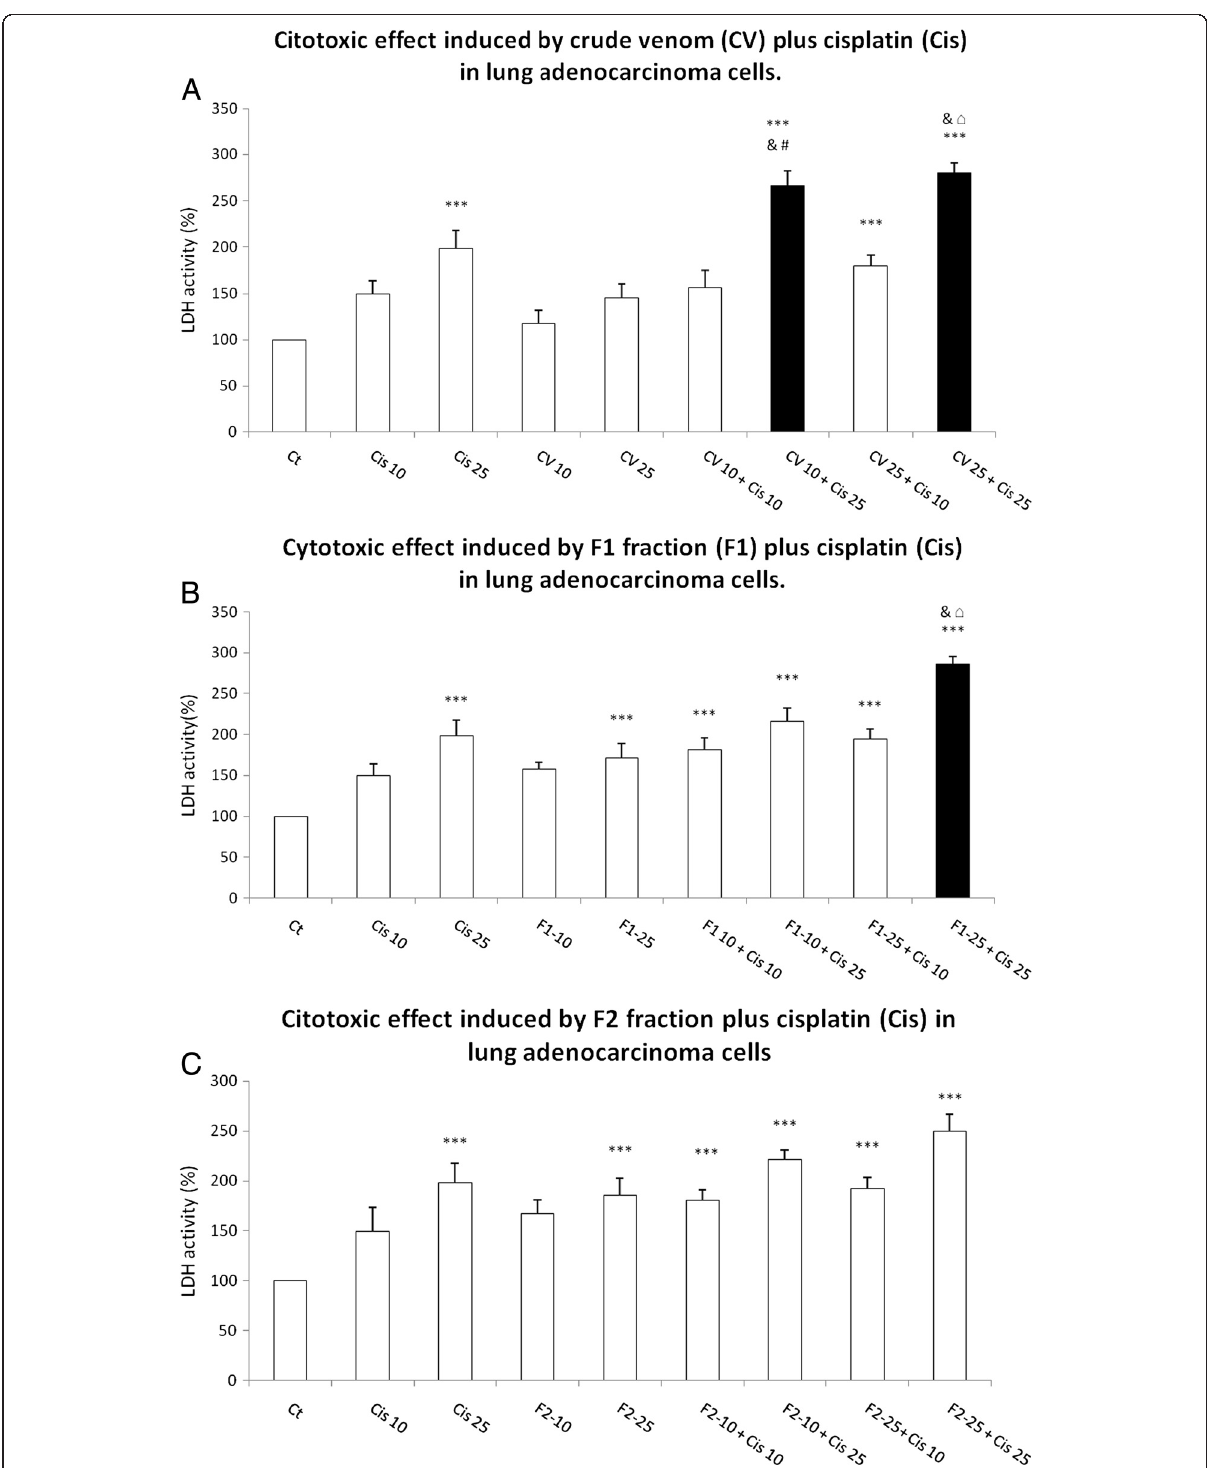
Figure 5 Cytotoxic effect induced by CV, F1 and F2 fraction from B. globulifera on adenocarcinoma lung cell culture: (A) CV, (B) F1 fraction plus cisplatin, (C) F2 fraction plus cisplatin. Graphs show the percentage of LDH release, with data expressed as the mean ± SD of four independent experiments. *** p < 0.001 vs. control, $ p < 0.001 vs. Cis 10, & p < 0.001 vs. Cis 25, # p < 0.001 vs. CV 10 or F1-10 or F2-10, □ p < 0.001 vs. CV 25 or F1-25 or F2-25 (one-way ANOVA, Bonferroni ’ s post test) (a) CV plus cis, (b) F1 plus cis, (c) F2 plus Cis. Gray bars showed the ability of ( B ) F1 and ( C ) F2 to increase the cisplatin-induced LDH